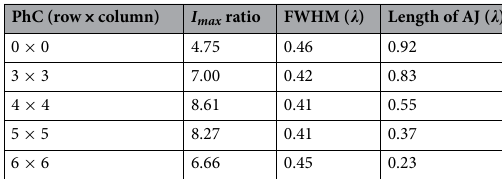
Table 2. Numerical parameter results for 4 (cid:31) radius ABS cylinder with different PhC sizes.